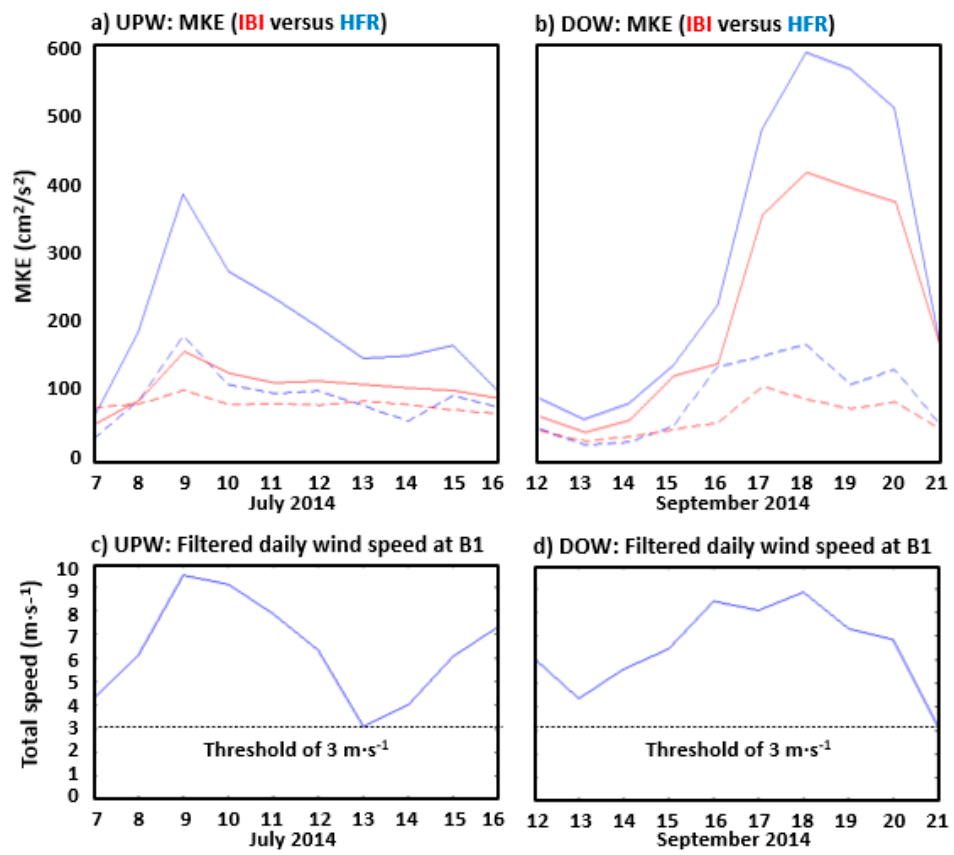
Figure 6. ( a ) Evolution of daily mean kinetic energy (MKE) under upwelling (UPW) conditions, averaged over the shelf (solid lines) and open waters (dashed lines), derived from hourly surface currents provided by the HFR (blue color) and IBI model (red). ( b ) Idem, under downwelling (DOW) conditions. ( c , d ) Evolution of daily averaged low-pass filtered wind speed (module), derived from hourly estimations at B1 buoy, during the UPW and DOW events, respectively.